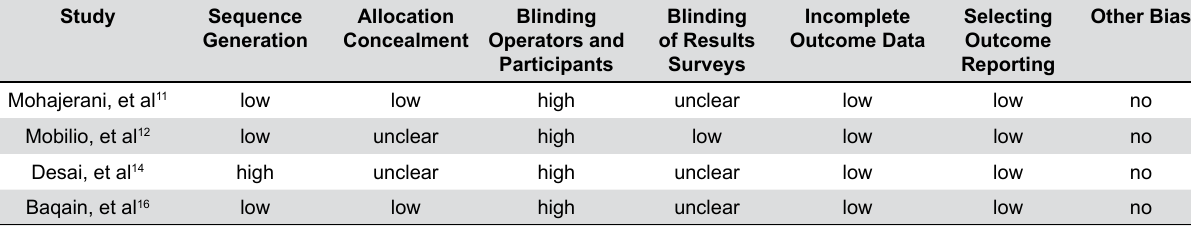
Table 4- Risk of bias assessment of included RCTs using the Cochrane’s Risk of Bias